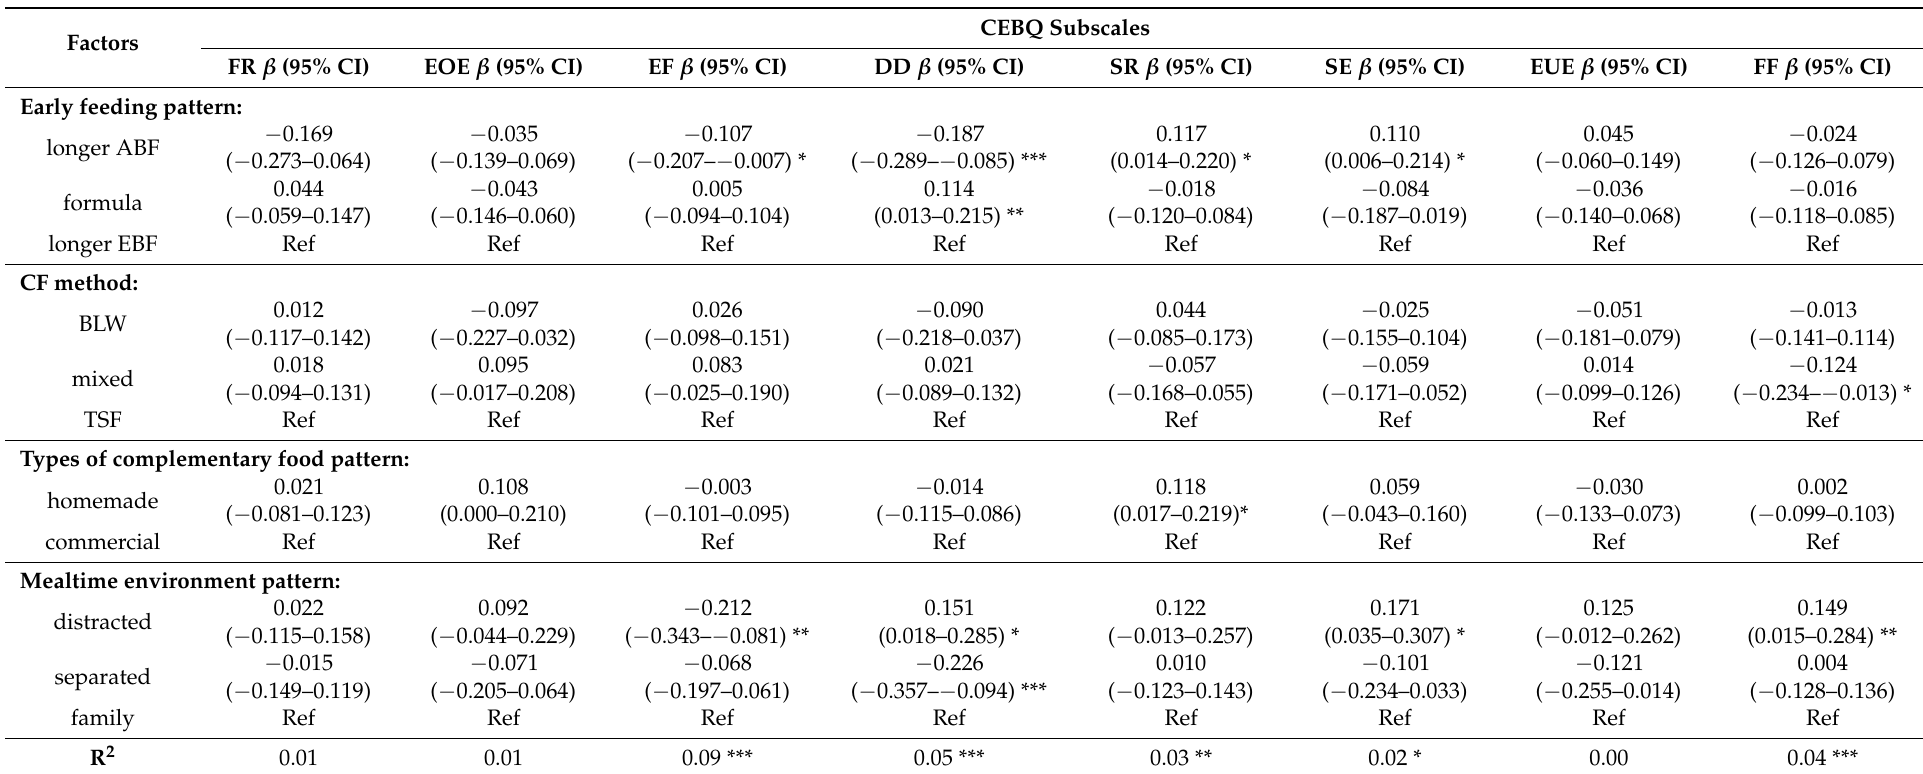
Table 3. Multivariate regression analysis predicting eating